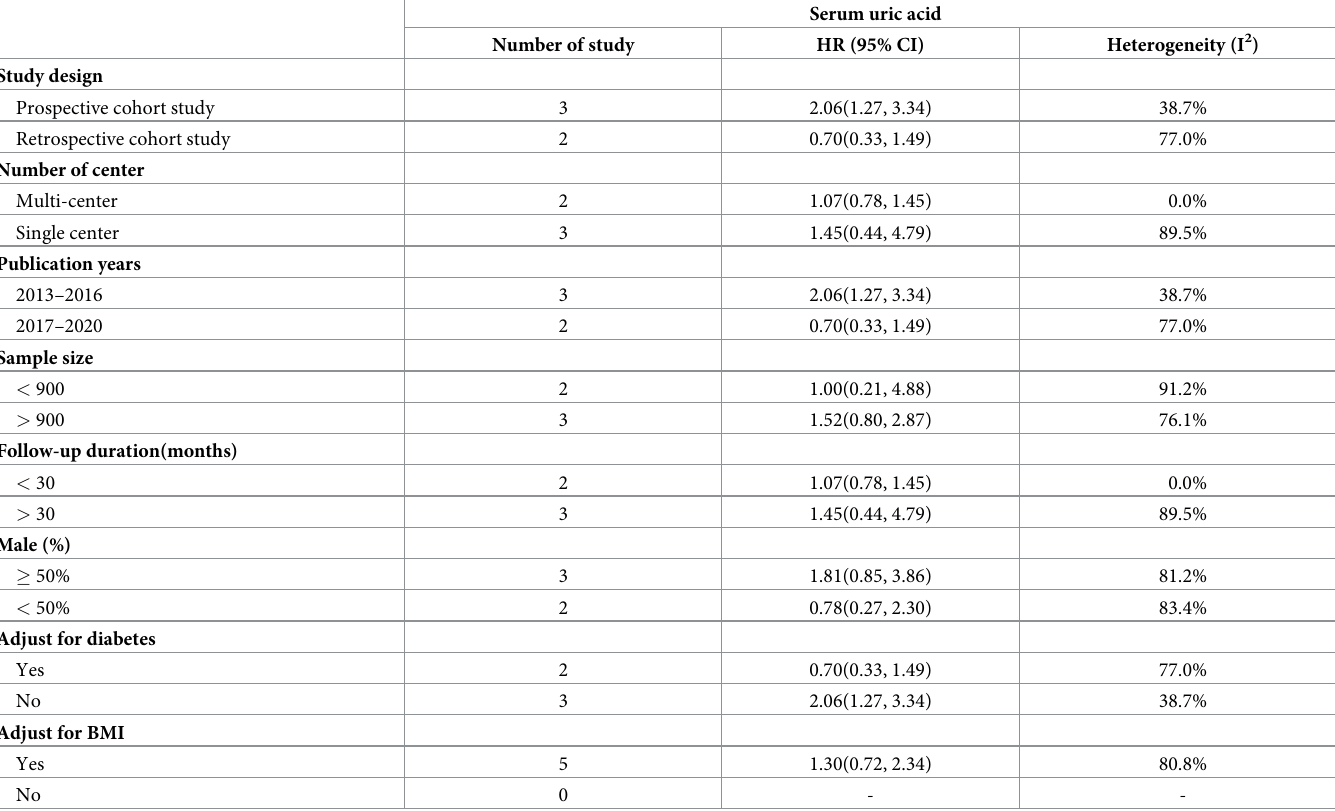
Table 3. Subgroup analysis of the relationship between serum uric acid and cardiovascular